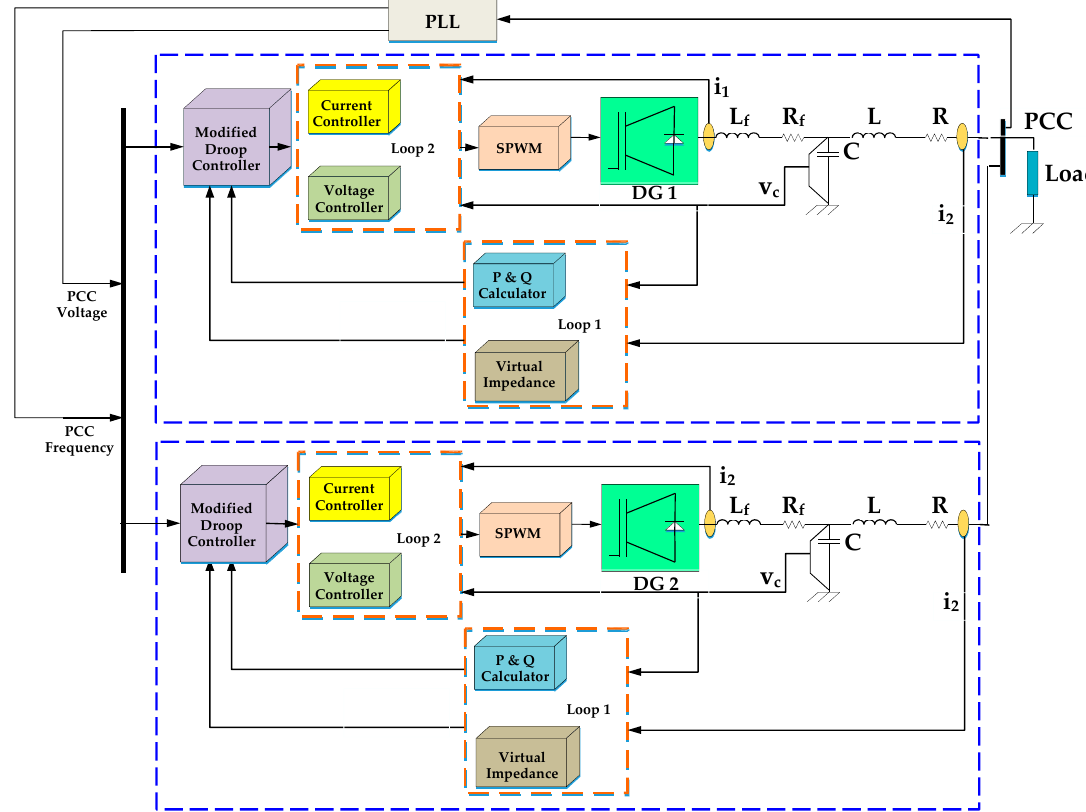
Figure 2. The control scheme block diagram for two islanded MGs.